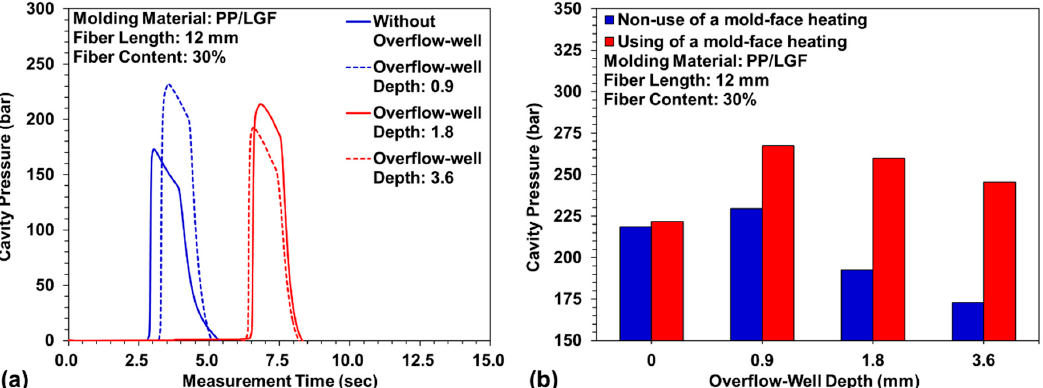
Figure 9. Variation of cavity pressure: ( a ) absence and presence of overflow-well; and ( b ) non-use and use of mold-face heating process.